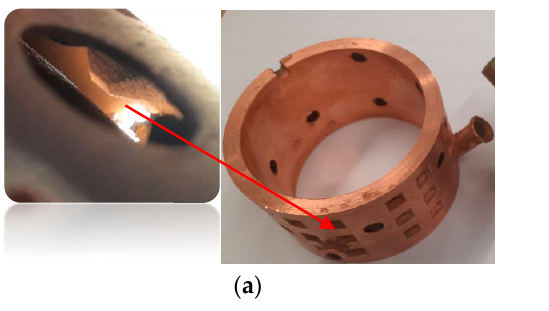
Figure 8. Manufactured sectors of the collector: ( a ) considering the difference in TEC and ( b ) with- out.